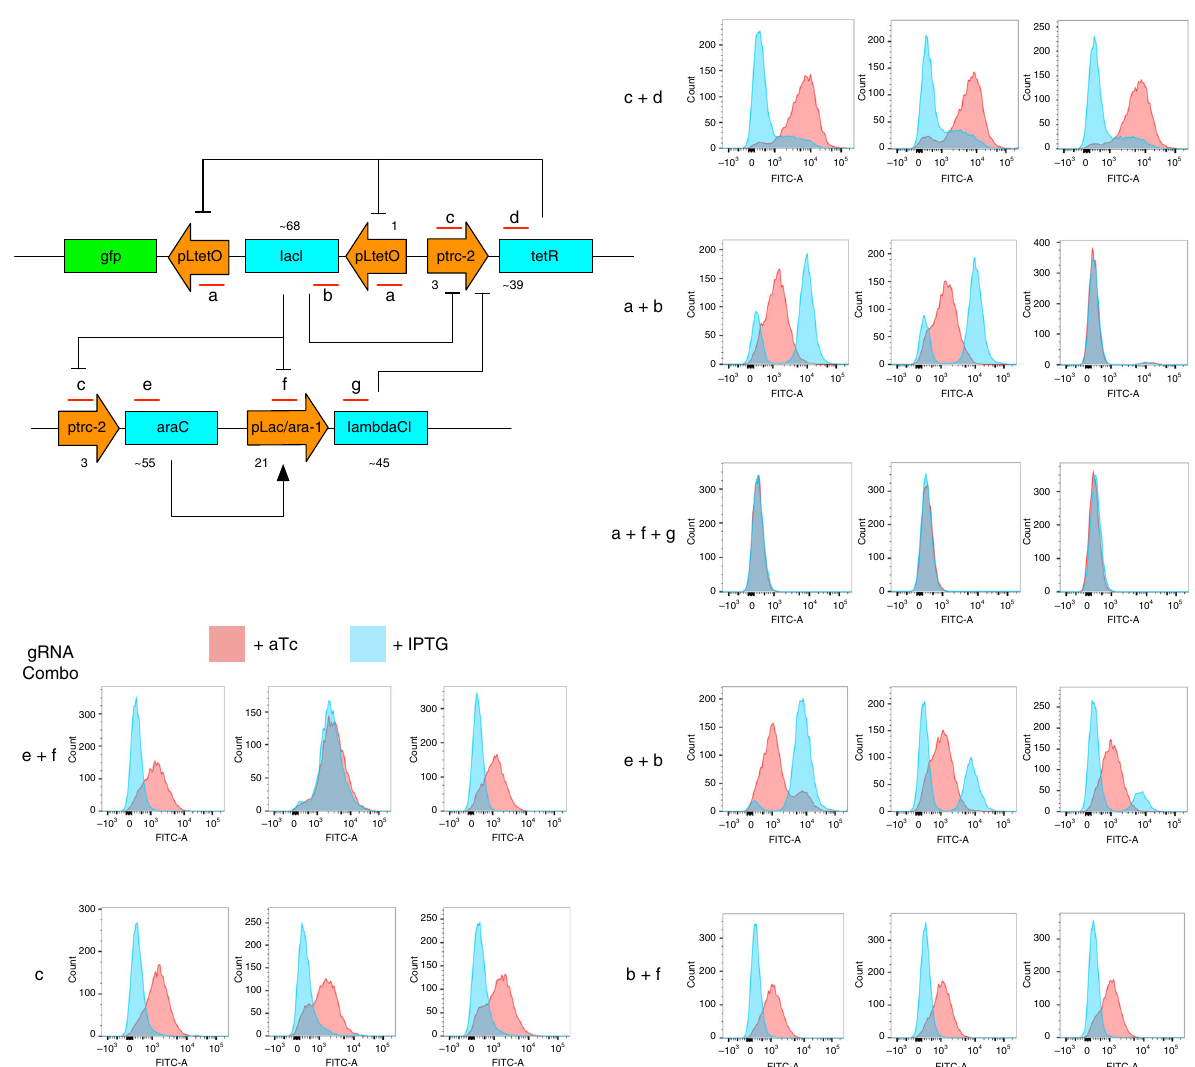
Fig. 5 Uncamou fl aging using incorrect keys. The camou fl aged circuit is re-drawn. gRNA targeting positions are shown as a red bar. gRNAs e + g form the correct key, used in Fig. 2. Numbers next to the promoters and ORFs denote the number of potential gRNA-binding sites (i.e., sequences adjacent to an NGG PAM). Histograms show GFP output from incorrect keys. Cell induced with + aTc are represented as red histograms, cells induced with + IPTG are represented as blue histograms. Each experiment was performed in triplicate — each histogram represents one biological